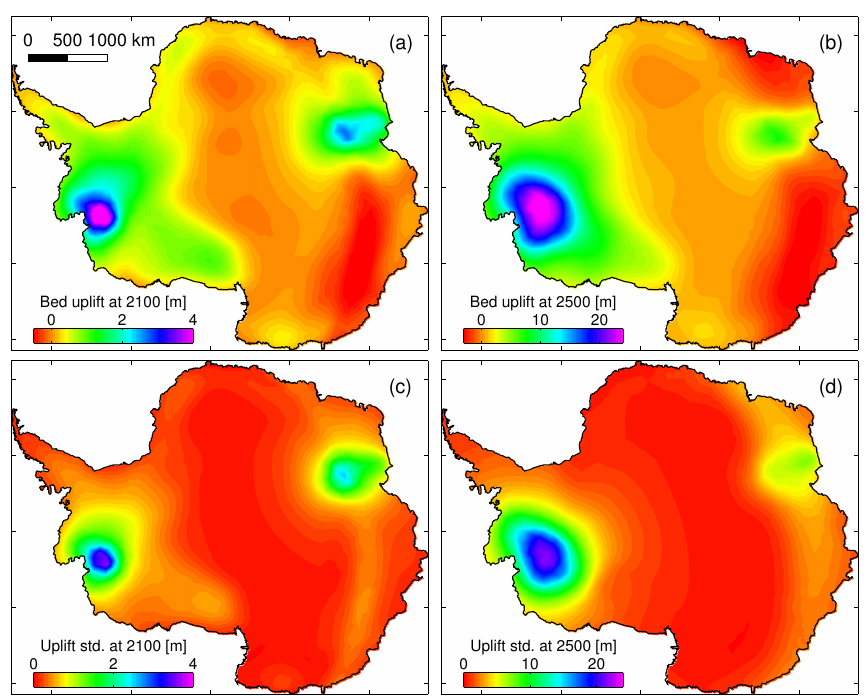
Figure 3. Estimates of the future Antarctic bed uplift. Model-average predictions for bed uplift at (a) AD 2100 and (b) AD 2500 under the R8 scenario. Associated standard deviations are shown in subplots (c) and (d) , respectively. Calculations are made by forcing the calibrated ISSM/GIA model (Fig. 2) by the future ice loading (Supplement Fig. S3) obtained from the SeaRISE project (Bindschadler et al., 2013; Nowicki et al., 2013). See Supplement Fig. S6 for corresponding solutions for the bed uplift rate. Roughly similar spatial patterns are obtained, with the respective range of values [− 5 , 45 ] and [− 15 , 75 ] mmyr − 1 at AD 2100 and AD 2500.